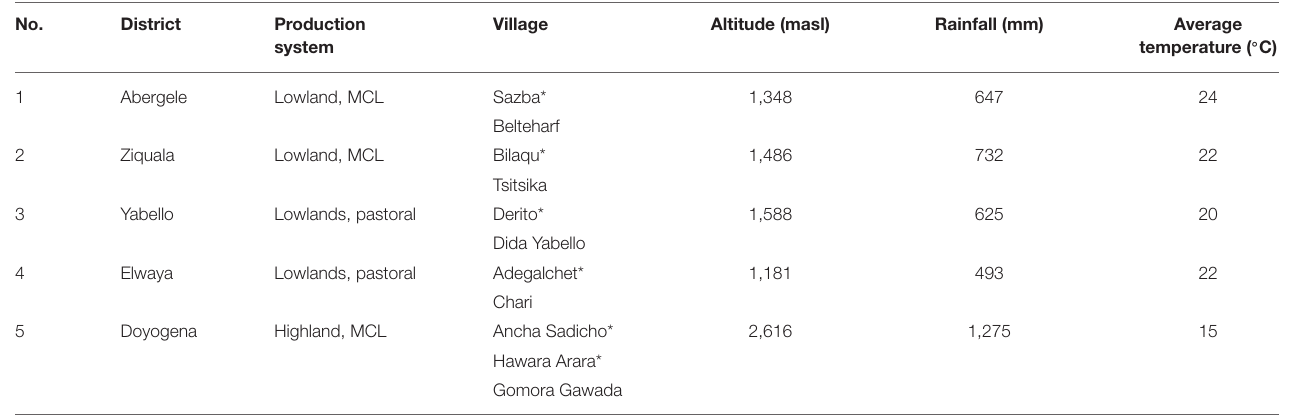
TABLE 1 | Description of study areas in